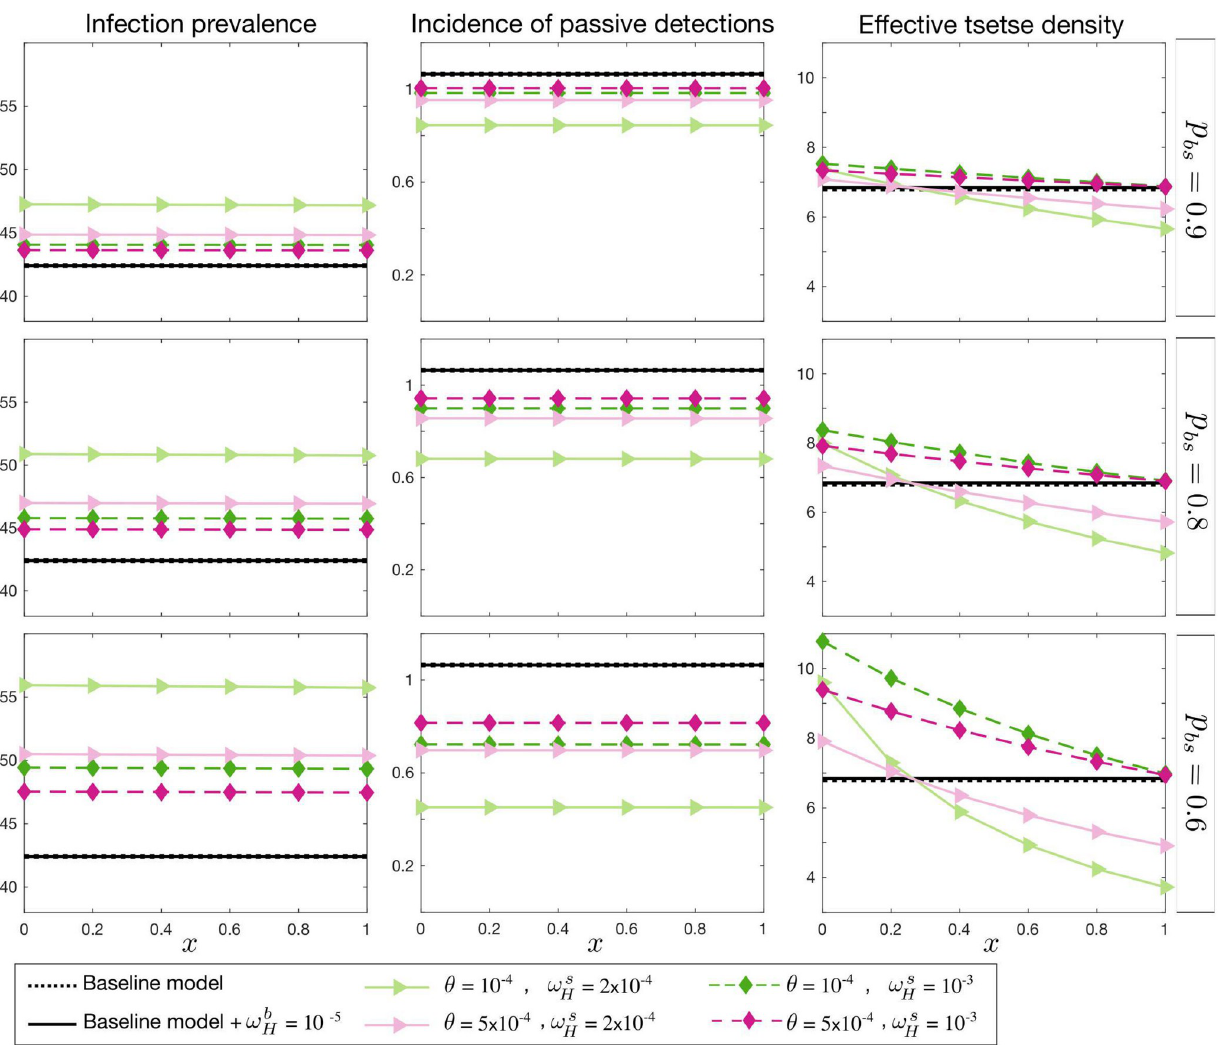
Fig 3. Endemic equilibrium with fixed R 0 . Total prevalence, I H , observable incidence, u γ H ( Y ) I 2 H , and the effective tsetse density, m eff , are plotted as a function of x , the relative infectiousness of skin-only infections compared to blood infections. The proportion of blood to skin-only infections, p for each row and different values of the self-curing skin-only infection rate, o s , and the skin-only to blood infection progression rate, θ , are shown with H various colours. There is no skin-only infection, p = 1, for the black lines; the dashed line represents the baseline model (with no asymptomatic bs components) and the solid line represents the baseline model but with the possibility of self cure from first-stage blood infection, I b The prevalence and incidence are given per 10,000